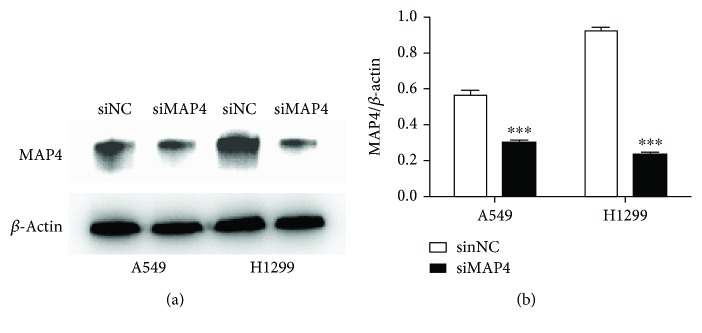
MAP4 expression was repressed by MAP4 siRNA in lung cancer cells. A549 and H1299 cells were transfected with siRNA against MAP4 and negative control sequence (siNC). Expression levels of MAP4 protein in siMAP4-transfected cells were significantly lower than those in siNC-transfected cells by Western blot analysis (a). Densitometry analysis of MAP4 expression in siMAP4-transfected A549 and H1299 cells (b). β-actin levels served as a loading control. The ratio of MAP4 expression to β-actin was calculated and represented as mean + SD relative to the control (∗∗∗P < 0.001, Student's t-test).